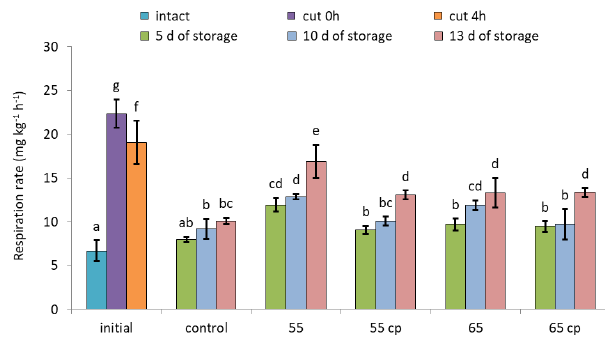
Figure 4. Respiration rates of short-term hot-water treated and untreated fresh-cut apple slices at days 5, 10 and 13 of storage in sugar syrup at 4 °C, compared to intact apples and untreated fresh-cut apple slices (initial). Given are means ± standard deviation ( n = 3). Different letters indicate significant differences between means ( p < 0.05). di ff erences between means ( p < 0.05). 5 d = 5 days, 10 d = 10 days, 13 d = 13